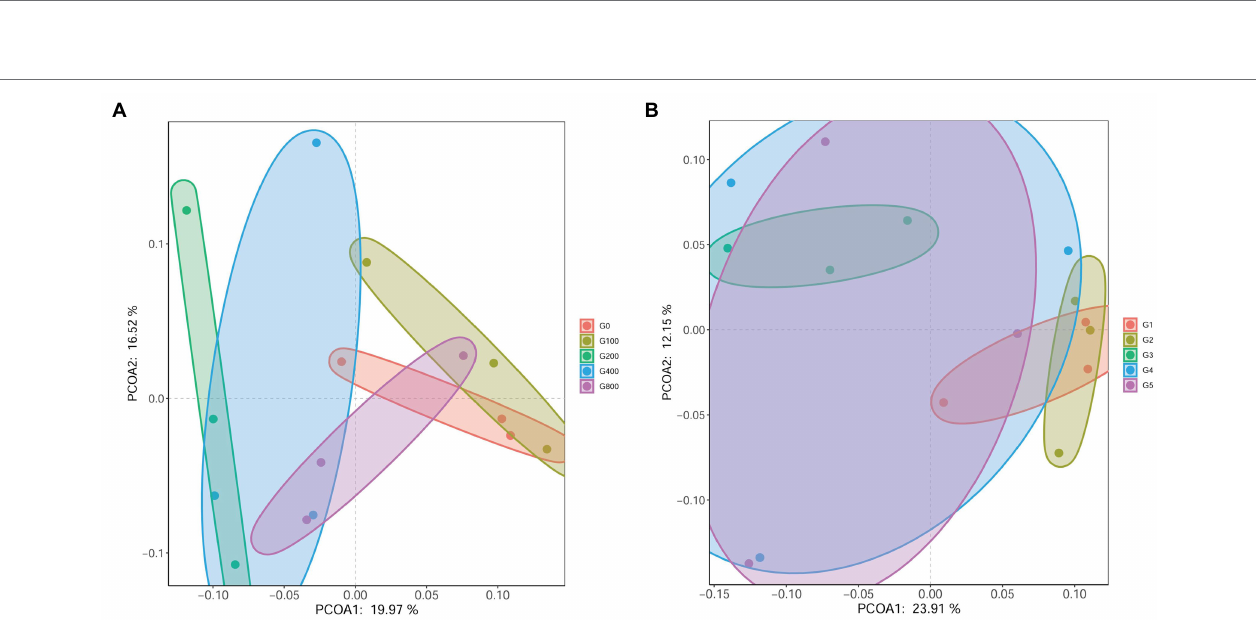
FIGURE 6 | Heatmap analysis of the species abundance clustering in the top 20 on the phylum level (mean ± SD, n =